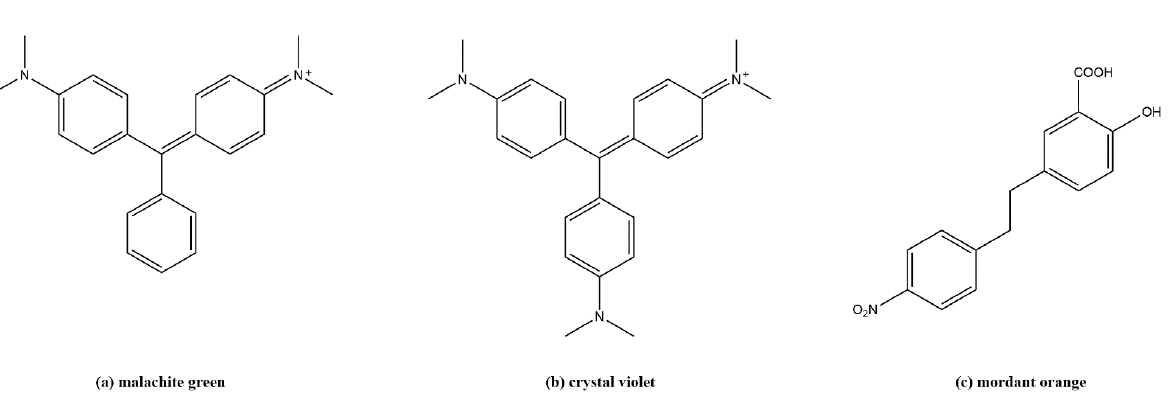
Figure A1. The chemical structure of ( a ) Malachite green, ( b ) Crystal violet, and ( c ) Mordant orange.